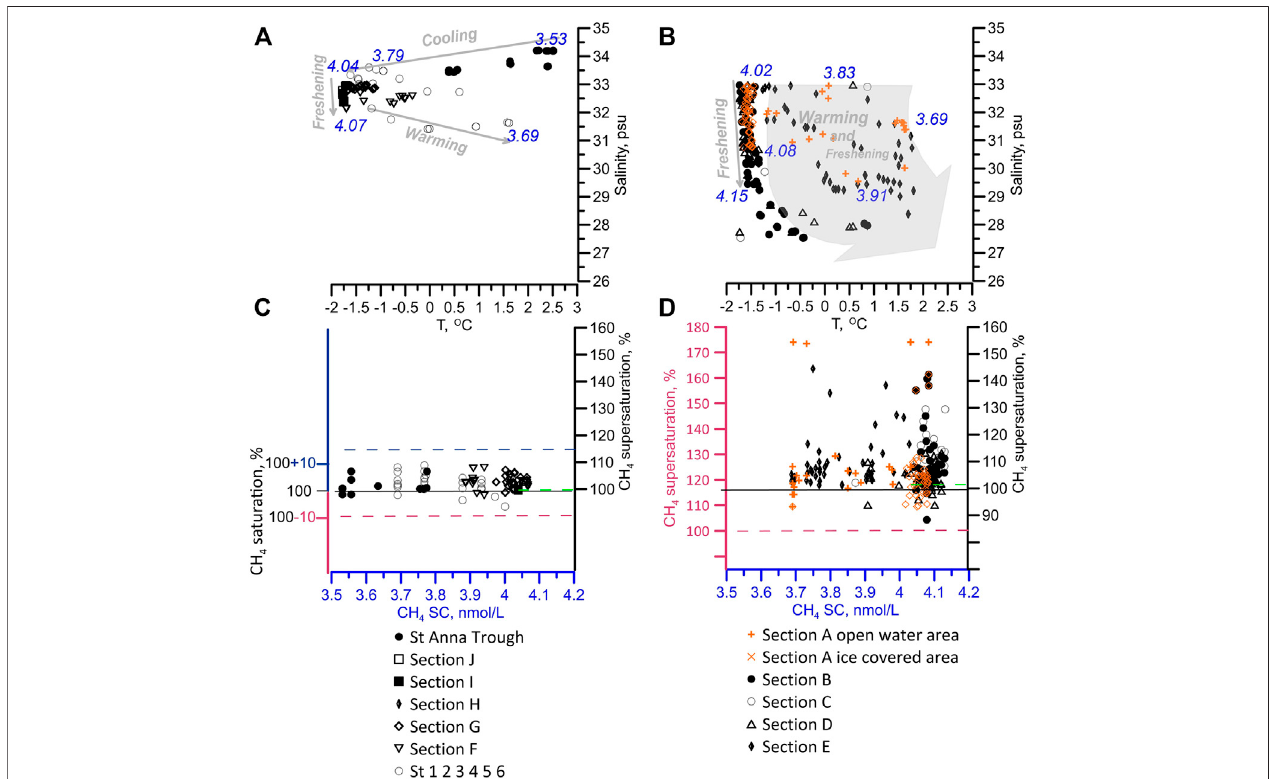
FIGURE 2 | The effect of the CH 4 solubility on the level of CH 4 saturation, related to the atmospheric equilibrium in the PML. The (A,B) gives the CH 4 solubility concentration (blue numbers) calculated in relation to the water temperature and salinity. The arrows show the dominant effect of either cooling or warming and freshening in the WES (A) , and EES (B) . The (C,D) shows the shift related to the saturation induced by changing solubility (dashed lines): in blue (cooling), in green (freshening),and inred (warming)inthe WES (C) and EES (D) . Theshiftinsaturationforced bypredominantly bywarming (left red axes)consistedinrealsaturation (rightblack axes) (D) . Orange symbolsindicate the referencesection A.In the WES the enhanced solubility masked the CH 4 supersaturation caused by marine sources. In the EES, CH 4 supersaturation is clearly induced by marine CH 4 sources.